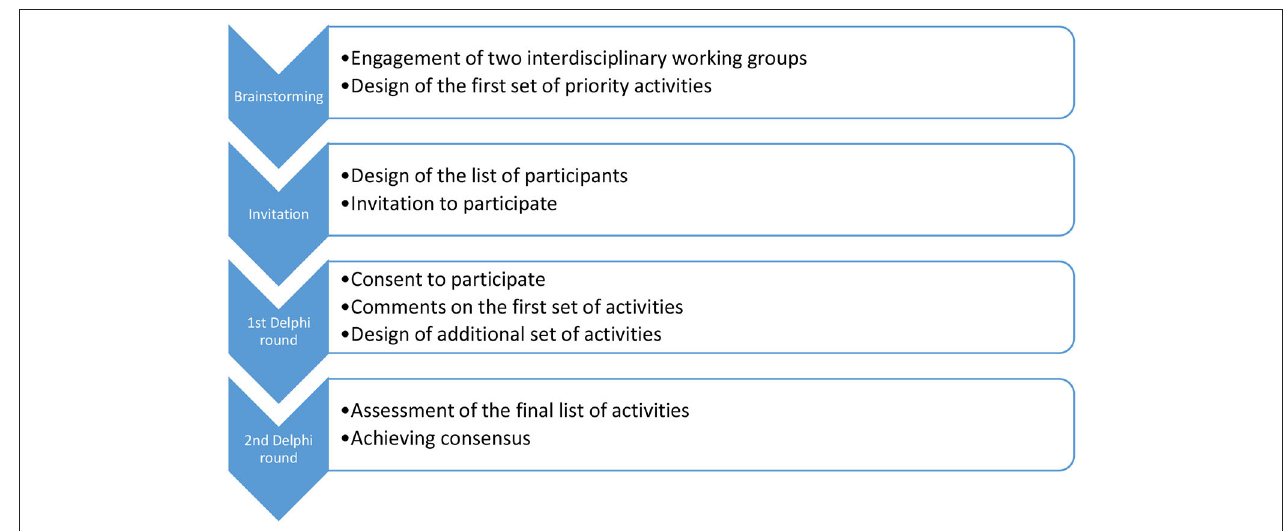
FIGURE 1 | Workflow of the Delphi